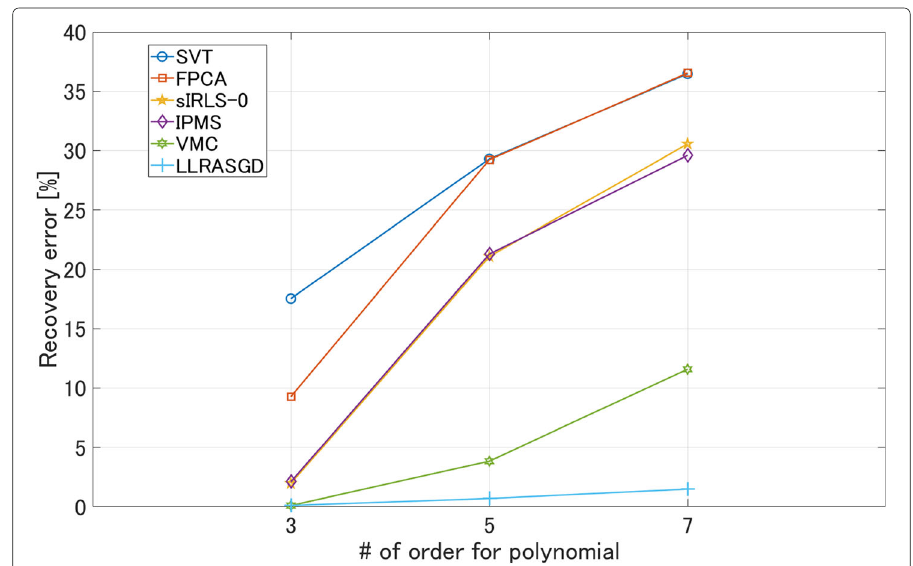
Fig. 4 Average RE for 10 trials with p = 3,5,7 for (20), r = 3 and q = 0.3